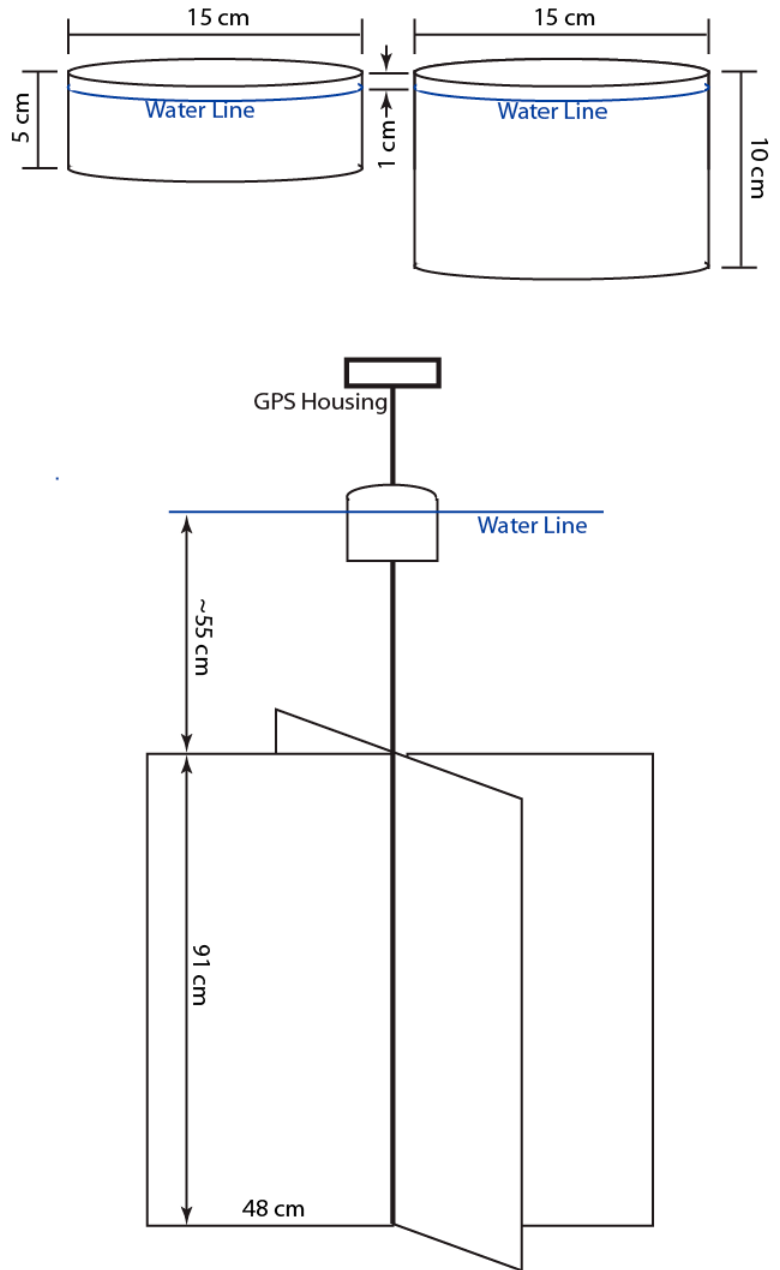
Figure 2. Schematics of 5-cm ( top left ), 10-cm ( top right ), and CODE-style ( bottom ) drifters.